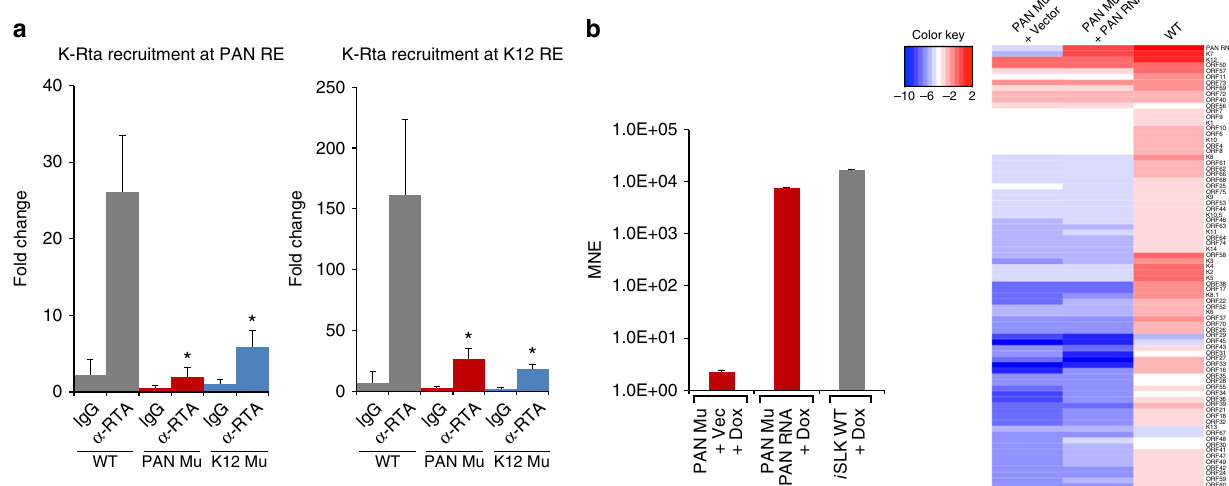
Fig. 5 Lytic gene expression involves clustering of RE sites and requires PAN RNA in cis . a Cross-talk between the PAN RE and K12 K-Rta RE i SLK cell lines harboring BAC16WT, PAN Mu, or K12 Mu bacmids were left uninduced or induced with dox for 8 h. Cells were fi xed and K-Rta ChIP was performed. Puri fi ed ChIP DNA was quanti fi ed by qPCR using primers that bracket the PAN RE (left panel) and the K12 RE (right panel) Values represent the mean ± SD of three replicates. Fold change is shown relative to the ChIP/input DNA signal in the uninduced cells. One K-Rta RE mutation impaired recruitment of K- Rta to the other RE. All α -RTA means differ signi fi cantly in pairwise comparisons to WT ( p < 0.01; one-way ANOVA with Tukey ’ s post-hoc HSD test). Fold changes between PAN Mu vs. K12 Mu α -RTA means are non-signi fi cant. b PAN RNA complementation of PAN RE mutant does not rescue defective KSHV gene expression. (Left panel) PAN RNA expression. The expression of PAN RNA with/without complementation was quantitated by RT-qPCR and compared to the expression of BAC16 WT. MNEs are derived from RNA harvested 48 h after dox-induction. Values represent MNE ± SD ( n = 3). ACTB expression was used as the reference. (Right panel) KSHV PCR microarray. Individual viral gene expression was examined by KSHV PCR array and visualized as a heatmap. The heatmap was generated using Version 3.2.2 of R software with heatmap.3